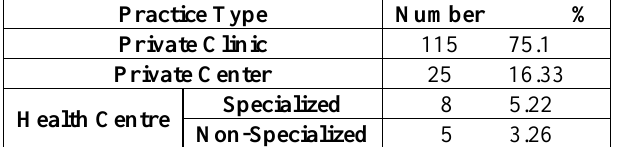
Table 1: Practice type among Sulaimani dentists (n=153).